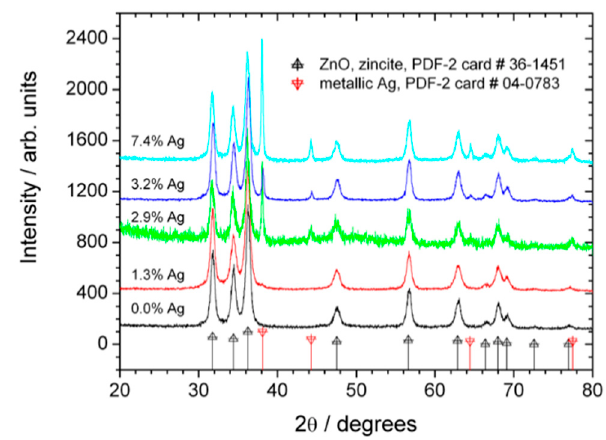
Figure 2. X-ray diffraction patterns of ZnO NPs and hybrid ZnO–Ag NCs. The main reflections from zincite (ZnO, JCPDS PDF-2 card number 36-1451) and metallic silver (Ag, JCPDS PDF-2 card number 04-0783) are included as drop lines.